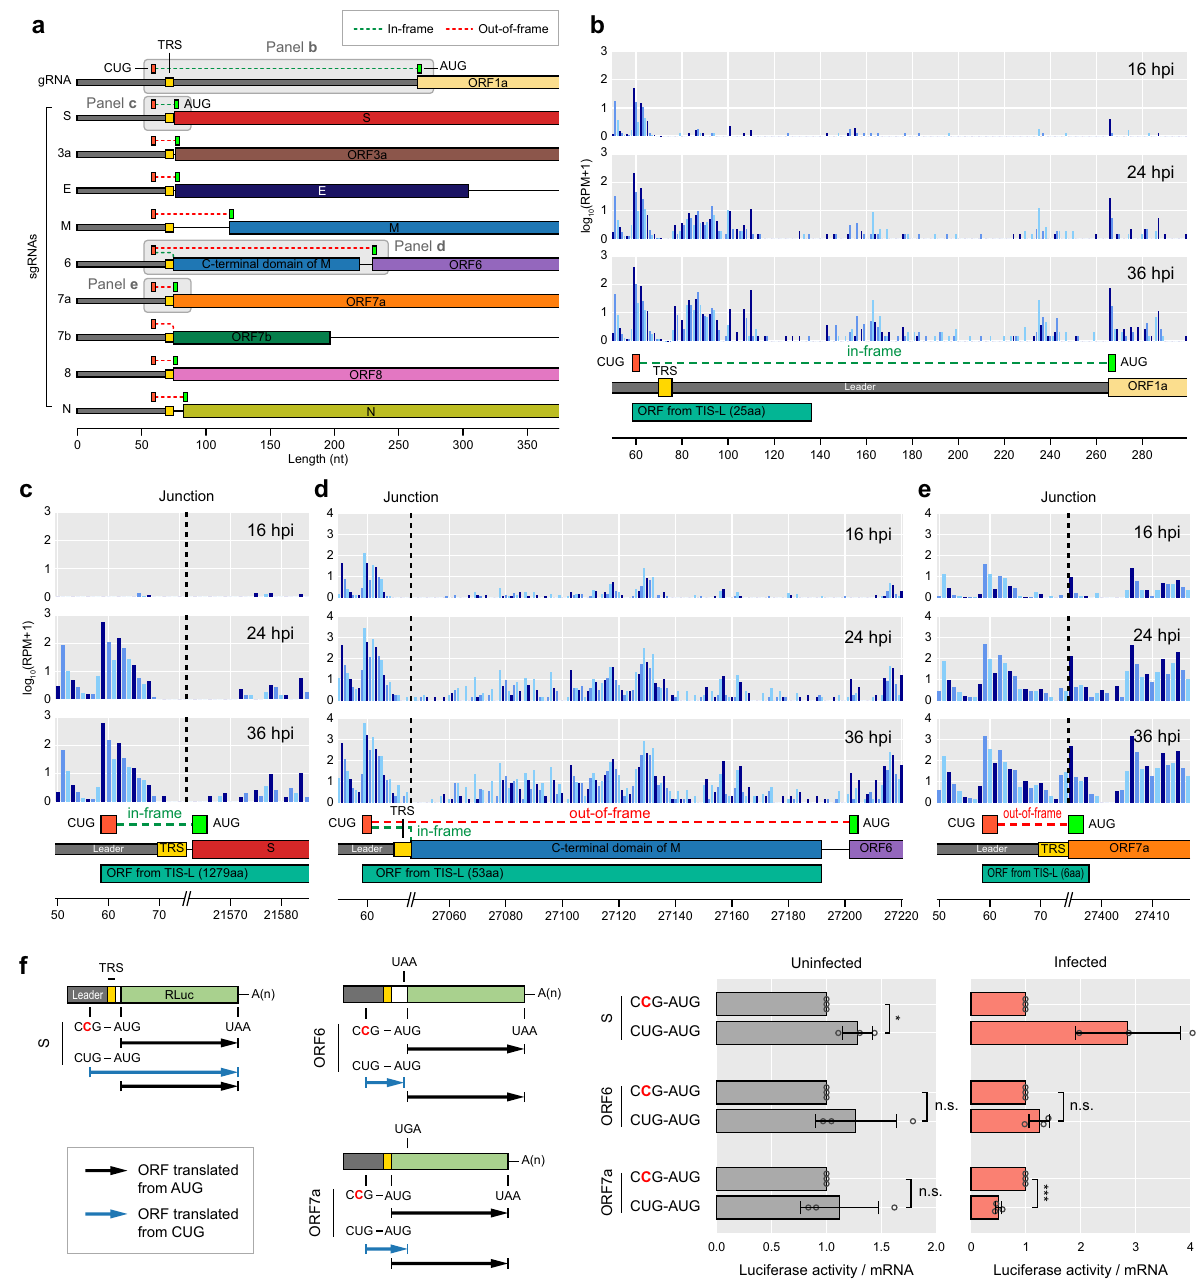
Fig. 4 Translation initiation site located in the leader (TIS-L) functions as a global regulator of the SARS-CoV-2 translatome. a Overview on the position of TIS-L in relation to ORF start codons of SARS-CoV-2 gRNA and sgRNAs. For each of gRNA and sgRNAs, positions of TIS-L (orange), transcription regulatory sequence (TRS, yellow), and start codon of ORFs (green) were displayed. The reading frame of each TIS-L-initiating hypothetical ORF was shown as a green (in frame) or red (out of frame) dashed line compared to the reading frame of the annotated ORF. RPF-seq reads mapped on TIS-L compared to those of the annotated ORFs 1a ( b ), S ( c ), 6 ( d ), and 7a ( e ), measured at 16, 24, and 36 hpi with their nucleotide sequence, annotation of each ORF, TRS, TIS-L, and a predicted ORF initiated from TIS-L shown below. For reading frames, the dark blue and the other blue bars indicate RPF-seq reads that are in frame and out of frame with the annotated ORF, respectively. The x -axis represents SARS-CoV-2 genomic position, and the y -axis represents log 10 (RPM + 1). The dashed lines indicate junction positions of each sgRNA. The ORFs that starts from CUG or TIS-L are depicted with its calculated protein sizes. Whether the CUG-derived hypothetical ORFs are in frame or out of frame with respect to the annotated downstream ORFs is also shown for each viral ORF. RPF-seq and QTI-seq reads mapped on the other ORFs are shown in Supplementary Figs. 7 and 8. f Experimental validation of TIS-L functions. A schematic diagram of RLuc reporters are displayed with the mutated sequences shown in red, designed to disrupt TIS-L-initiated uORF. Calu-3 transiently transfected with a RLuc reporter and a plasmid expressing FLuc mRNA were either infected or uninfected with SARS-CoV-2 and the relative RLuc activities were measured. RLuc and FLuc activities were normalized to RLuc and FLuc mRNAs, respectively (two-tailed, equal-sample variance Student ’ s t tests, * P < 0.05, ** P < 0.01, *** P < 0.001). The mean values ± s.d. are displayed ( n = 3 biologically independent experiments). P values are provided in Source